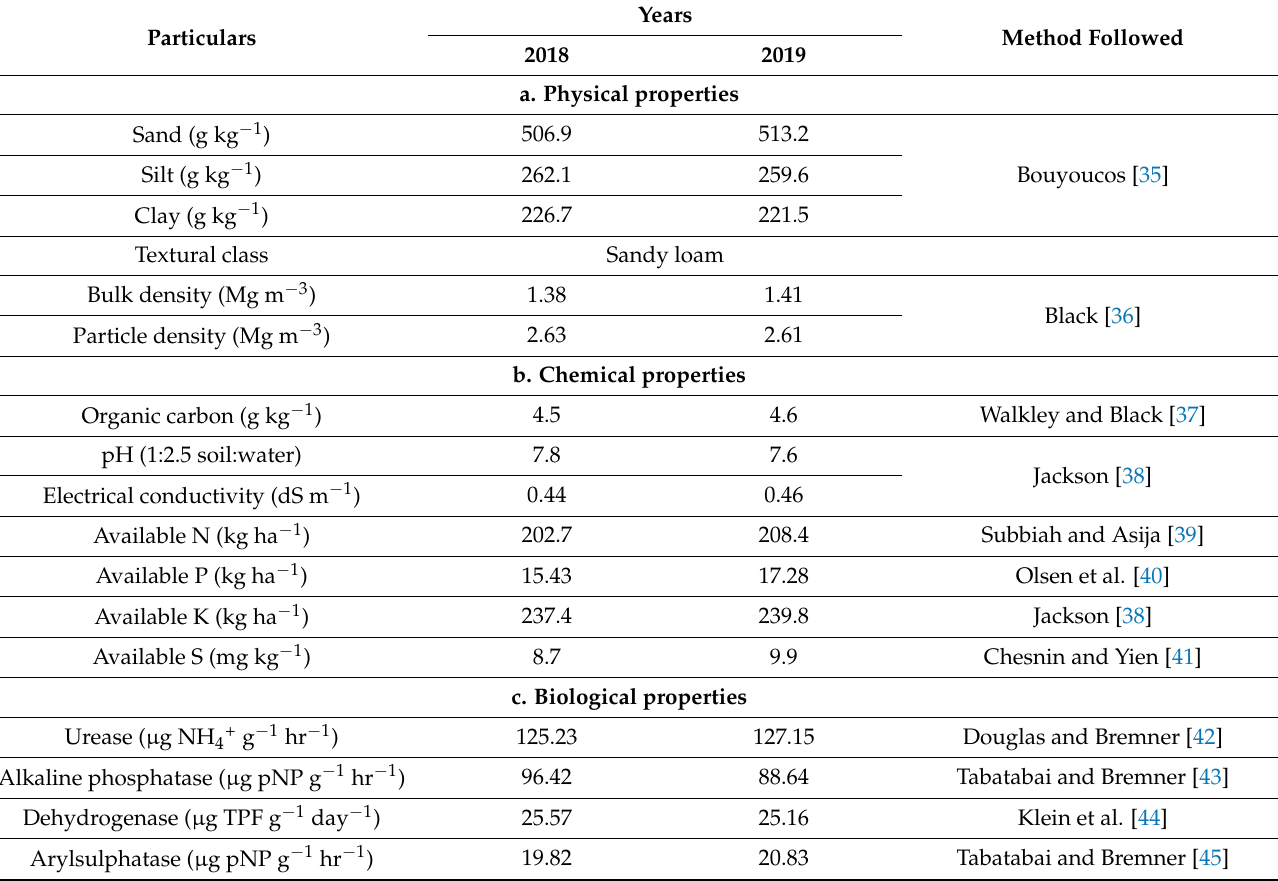
Table 1. Characteristics of the initial soil during the winter seasons of 2018 and